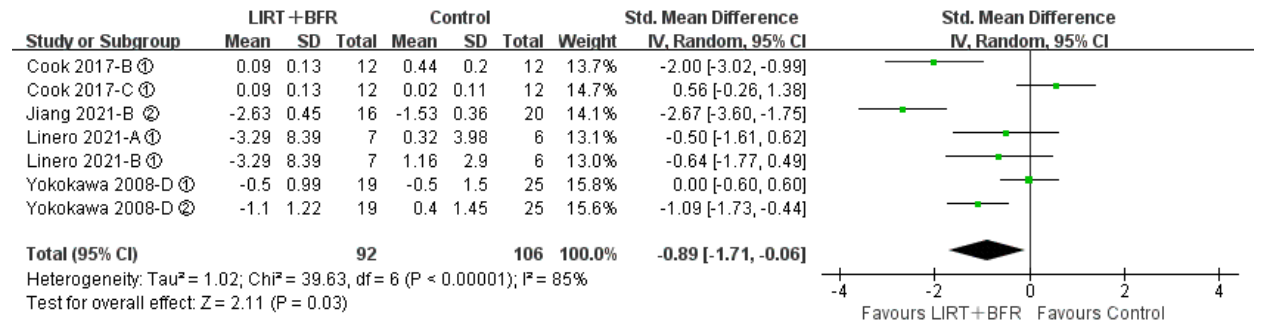
Figure 7. Meta-analysis of walking ability [18,21,27,30]. Figure Notes: A, LIRT + BFR vs. Daily exercise; B, LIRT + BFR vs. LIRT; C, LIRT + BFR vs. HIRT; D, LIRT + BFR vs. Dynamic Balance Exercise. ① Walking time(s). ② TUG(s).